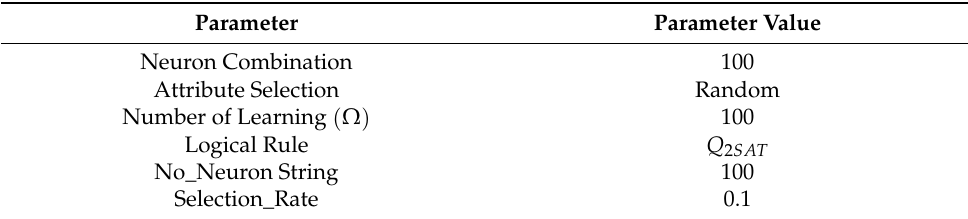
Table 4. List of parameters in 2SATRA